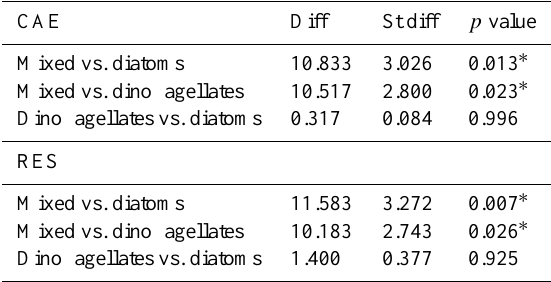
Table 3. Tukey’s post hoc tests of carbon parameters during ex- ponential growth phase. Only the statistically significant parame- ters from Table 2 were tested: carbon assimilation efficiency (CAE) and respiration (RES). The phytoplankton community was catego- rized according to diatom dominance (diatoms), mixed community (mixed) and dinoflagellate dominance (dinoflagellates). The stars ( ∗ ) indicate statistically significant differences ( α = 0 .